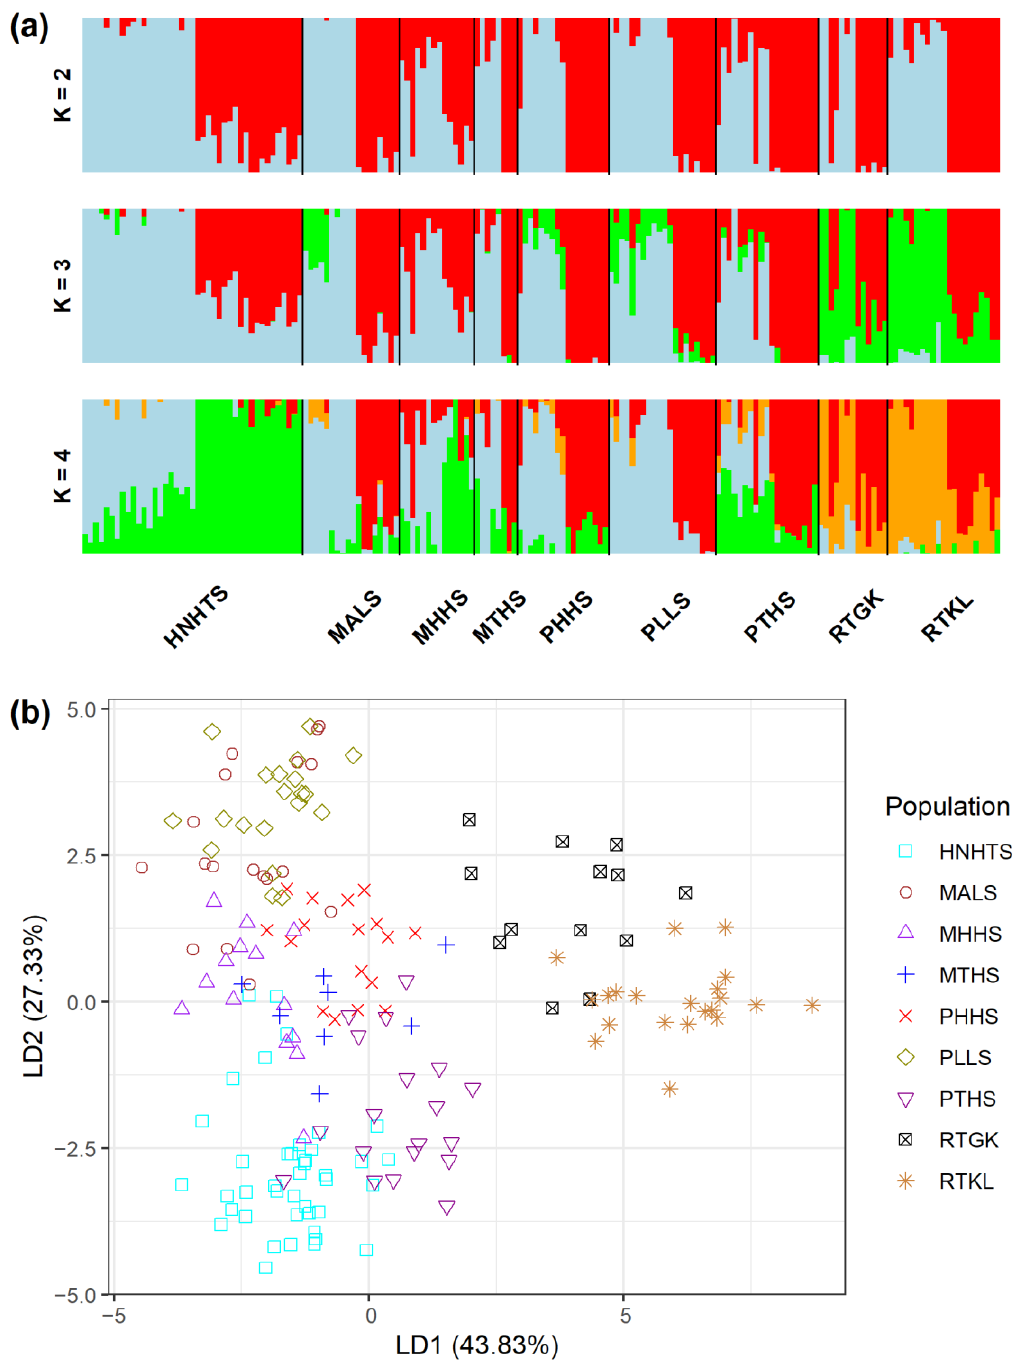
Figure 2. Analysis of genetic homogeneous groups of 171 individuals from nine populations of four closely related species in the Rhododendron pseudochrysanthum complex based on the total AFLP variation using ( a ) LEA and ( b ) DAPC. The clustering scenarios for K = 2 – 4 were displayed in LEA. LEA, landscape and ecological association [29]; DAPC, discriminant analysis of principal component [30,31].